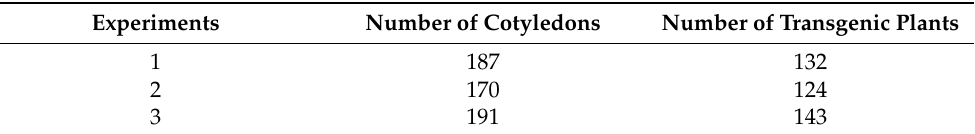
Figure 6. Assessments of the co-expression of GUS and GFP in transgenic tissues. Table 5. Validation of the optimized cassava SC8 transformation in 3 independent experiments using 1 mL SCV FECs.